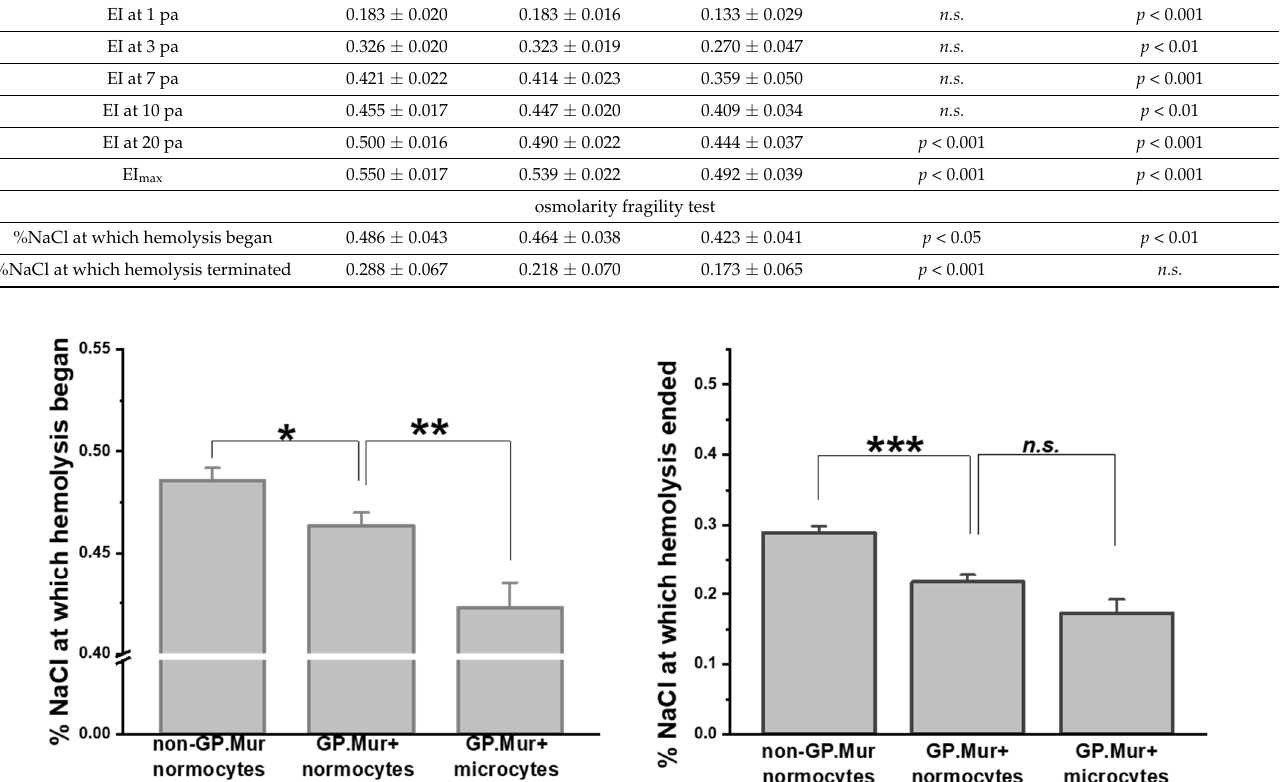
Figure 1. GP.Mur+ RBCs exhibited superior resistance to osmotic stress. Osmotic fragility tests showed that GP.Mur+ RBCs began and completed hemolysis at more hypotonic concentrations than non-GP.Mur cells. GP.Mur+ microcytes began hemolysis at even more hypotonic concentrations than GP.Mur+ normocytes, but GP.Mur+ microcytes and normocytes were not different in the %NaCl at which hemolysis terminated. Data are presented in mean ± SEM; * p < 0.05; ** p < 0.01; *** p < 0.001; n.s ., not significant.